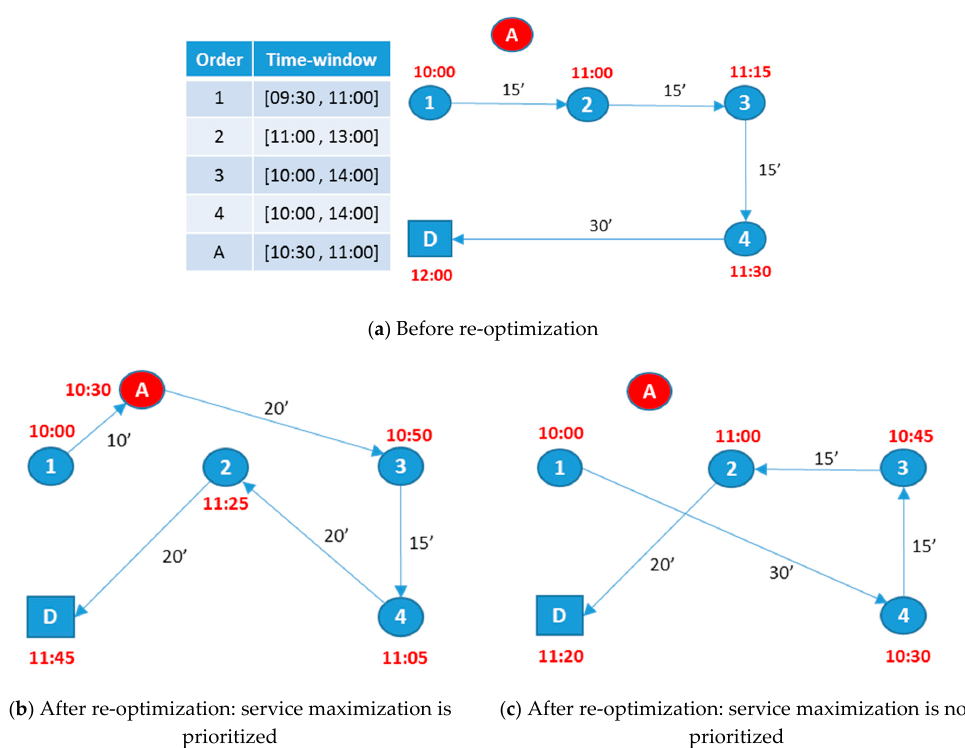
Figure 3. Example: comparing possible alternative expressions of objective ˇz 2 (A is the newly received dynamic order; 1, 2, 3, 4 represent the committed orders; D is the depot). ( a ) Before re-optimization; ( b ) After re-optimization: service maximization is prioritized; ( c ) After re-optimization: service maximization is not prioritized.